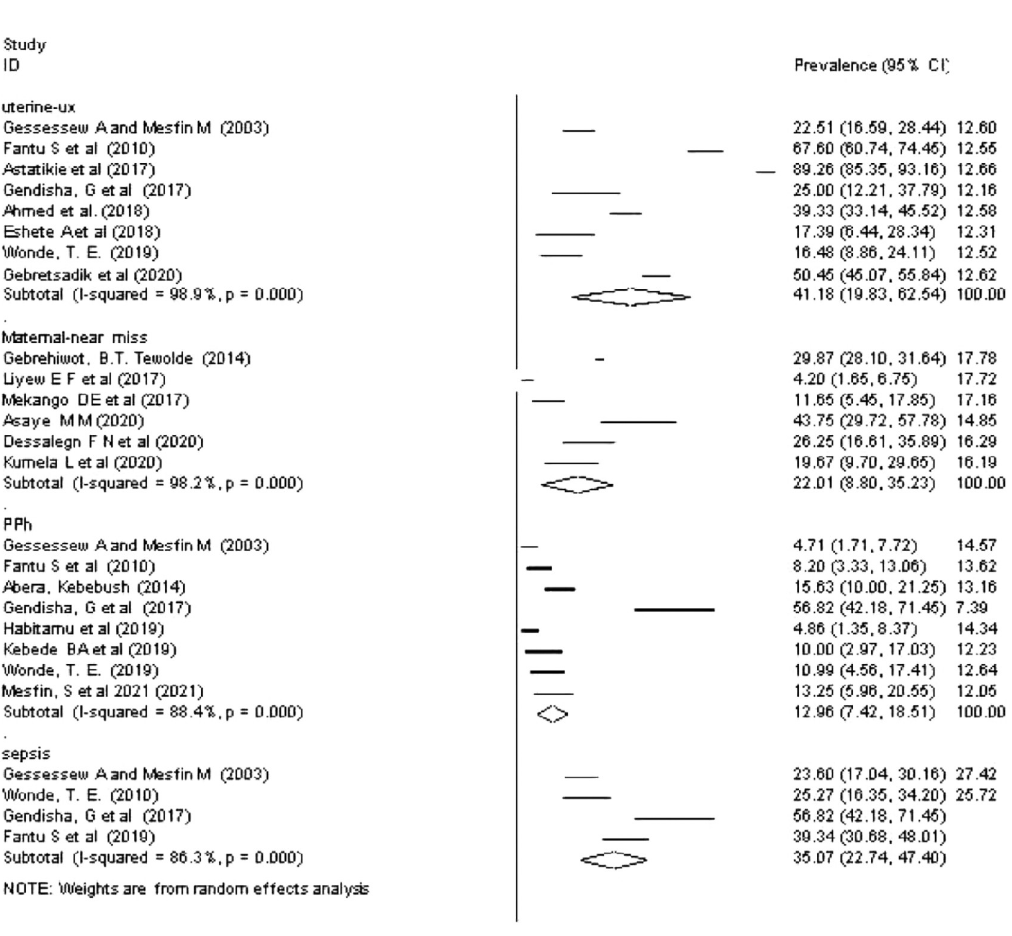
Fig 3. Forest plot of overall prevalence of severe maternal outcomes among obstructed labor women in Ethiopia, 2021.